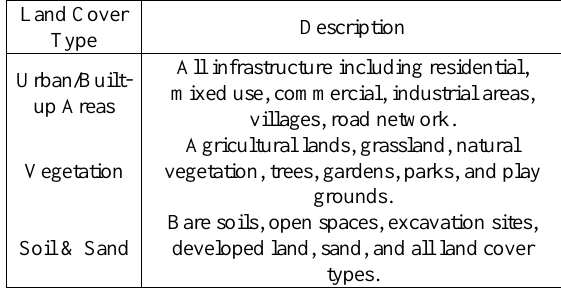
Table 2. Description of land cover types used in the